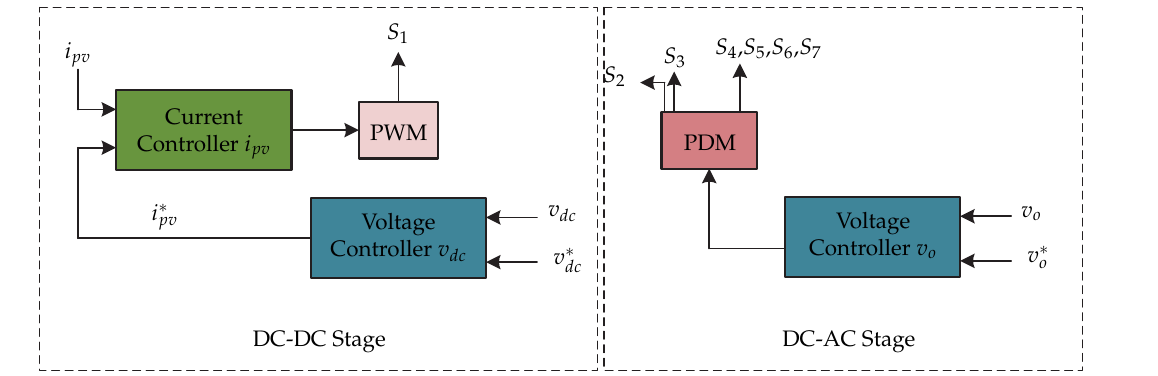
Figure 25. Control strategy proposed in [63].